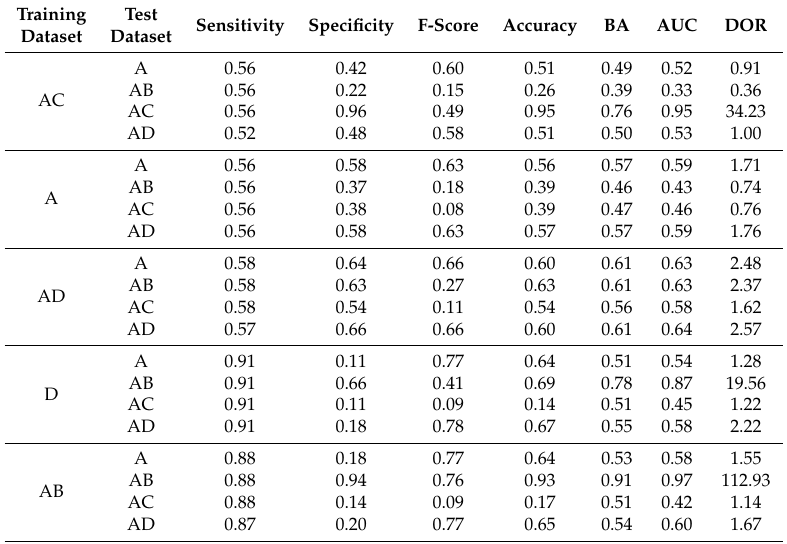
Table A1. Results obtained training a ResNet-18 model (no pre-trained encoder). Dataset naming follows Table 1.